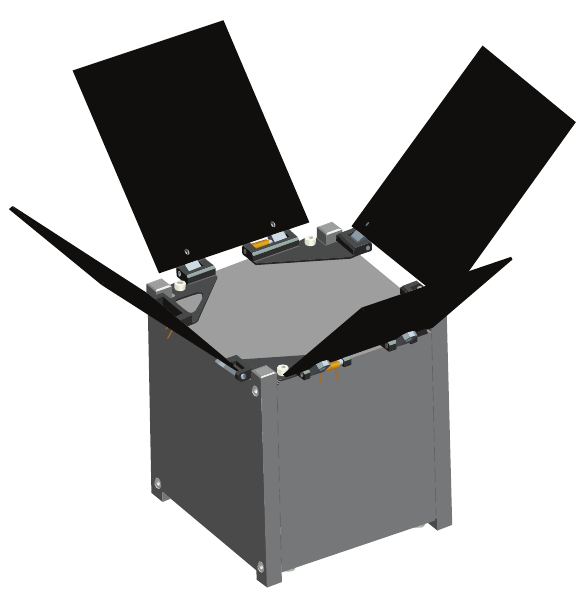
Figure 9: Deployable solar panels on PilsenCUBE